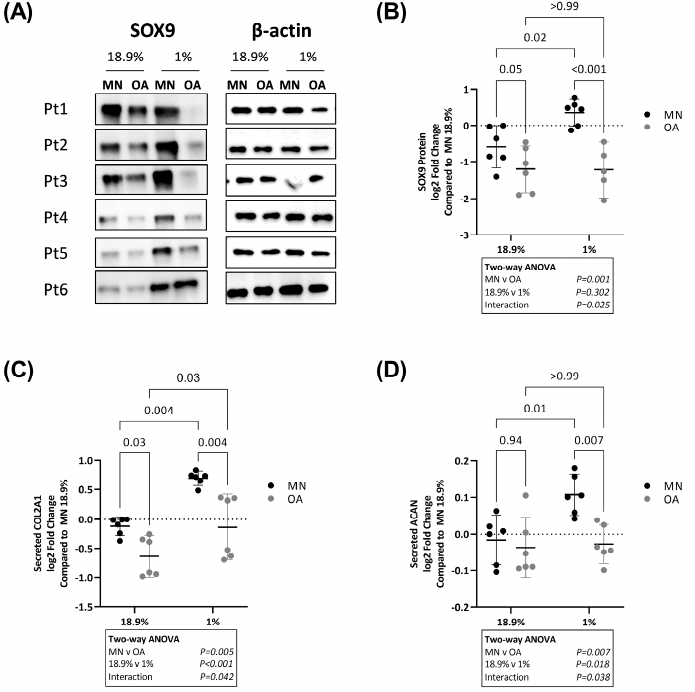
Figure 3. Protein levels of SOX9, COL2A1 and ACAN in OA chondrocytes and chondrocytes from macroscopically normal cartilage maintained in 18.9% compared to 6% or 1% oxygen. Paired samples of human chondrocytes isolated from macroscopically normal (MN) and osteoarthritic (OA) cartilage regions within OA joints from six patients were plated in duplicate plates. One plate was transferred to a standard tissue culture incubator (18.9% oxygen) and the other transferred to a hypoxia incubator maintained at 1% oxygen for 24 h. ( A ) Western blots showing SOX9 levels and ( B ) quantification of SOX9 protein expression using band densitometry in OA chondrocytes and chondrocytes from MN cartilage from 6 patient donors maintained at 18.9% vs. 1% oxygen. ( C ) Levels of secreted type II collagen protein and ( D ) levels of secreted ACAN protein as measured by ELISA in cell supernatants from OA chondrocytes and chondrocytes from MN cartilage maintained in 18.9% vs. 1% oxygen for 24 h. Data shown are mean ± 95% CI. All data were analysed by two-way ANOVA. Statistically significant differences between groups following post hoc testing are shown on graphs. p < 0.05 was considered statistically